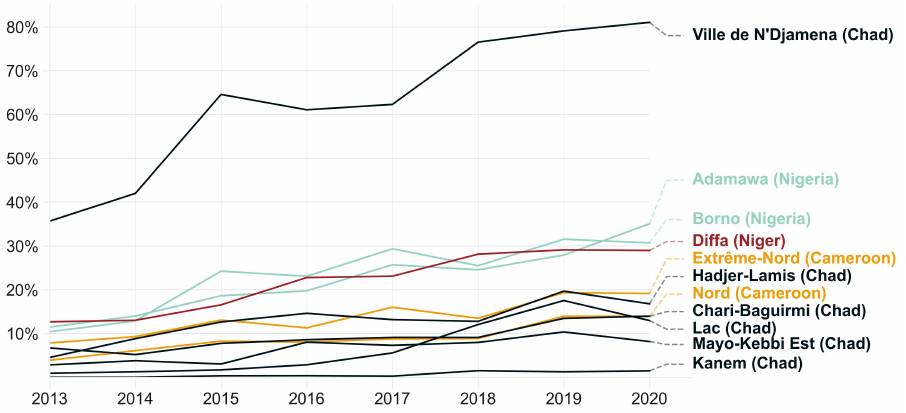
Figure 5. Lineplot of RAI on admin-1 level between 2013 and 2020, colour-coded by country: Chad (blue), Nigeria (turquoise), Niger (red), Cameroon (yellow).